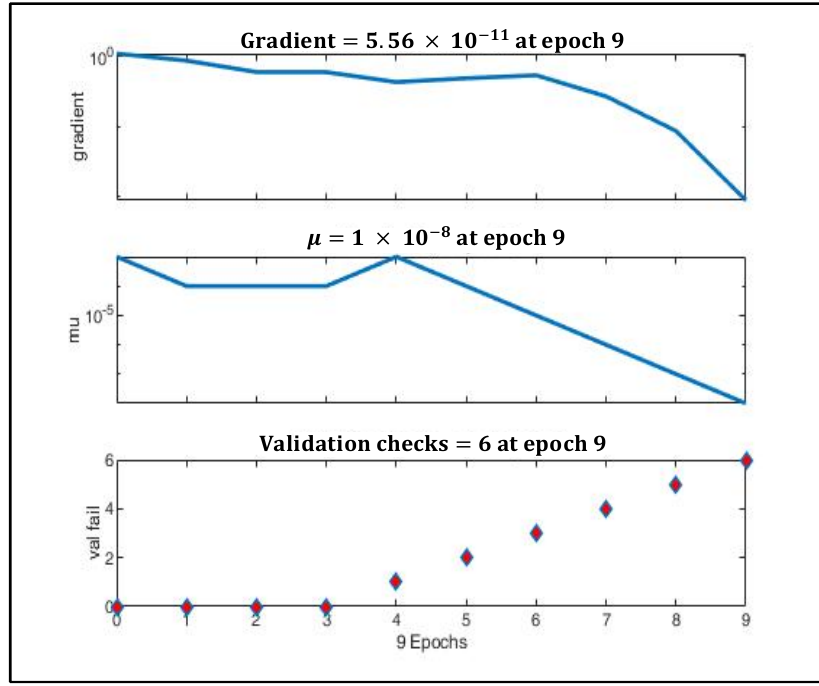
Figure 10. Gradient optimization using gradient descent and momentum.